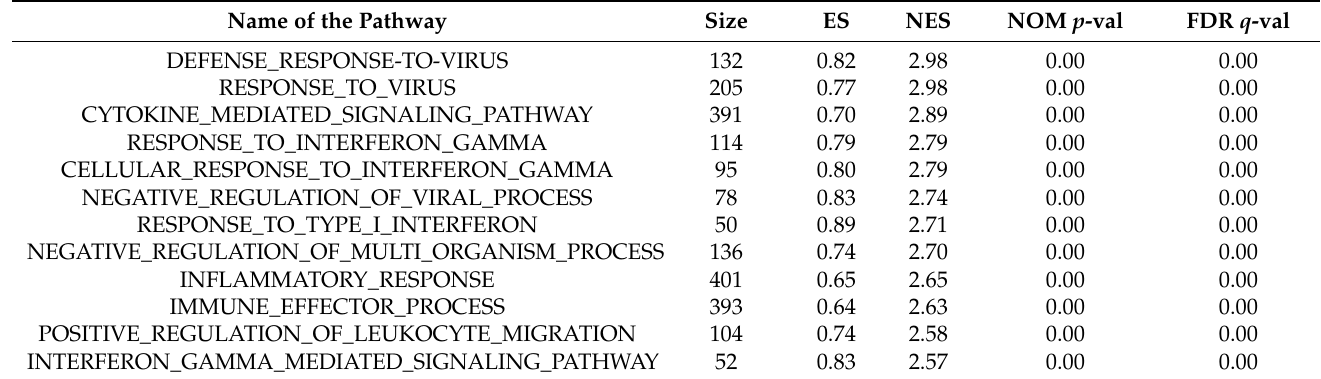
Table 3. Gene set enrichment analysis in P.BCG compared against the control. ES: Enrichment Score; NES: Normalized Enrichment Score; NOM p -val: Nominal p -value; FDR q -val: False Discovery Rate q -value; P.BCG: Mycobacterium bovis Phipps strain.